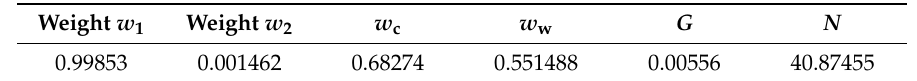
Figure 7. Relation between R tot and P p . Table 2. Parameter values of the optimization result.